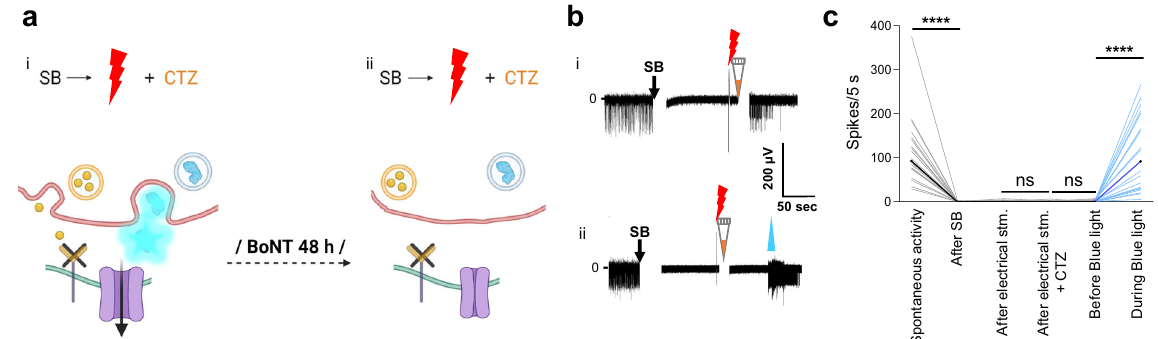
Fig. 5 Interluminescence is dependent on presynaptic vesicle release. a Schematics of synapses receiving synaptic blockers (SB) followed by electrical stimulation of presynaptic neurons together with CTZ application without (i) and after 48 h Botulinum Neurotoxin (BoNT) treatment (ii). b Representative trace of MEA recordings of opsin (ChR2(C128S)) expressing neurons without BoNT treatment (i, from Fig. 4diii) and 48 h after BoNT treatment of the co- culture (ii): electrical stimulation of presynaptic neurons together with CTZ application fails to elicit fi ring after BoNT treatment, while blue light still induces fi ring in the same recording. c Ladder plots of recording conditions as in ( b ) from electrodes across populations (comparisons are: spontaneous activity vs SB addition (after), n = 21, p < 0.0001; electrical stimulation (after) vs immediately following CTZ (after), n = 21, p = 0.7173; electrical stimulation + CTZ (after) vs blue light (before), n = 21, p = 0.6055; blue light (before) vs blue light (during), n = 21, p < 0.0001; Wilcoxon matched-pairs signed rank test). The artifacts due to addition of reagents in MEAs are overlaid by a vertical white bar in the recording traces (the white gap right after addition of SB or CTZ). Artifacts due to electrical stimulation are visible under the red bolts. ns, not signi fi cant; **** p <